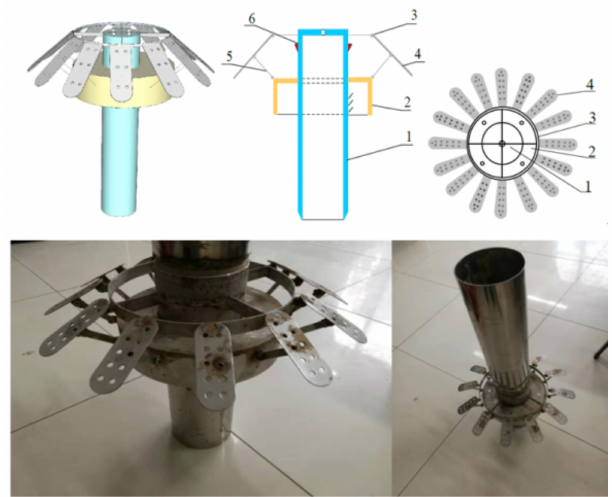
Figure 1. The close-up of umbrella suction anchor foundation